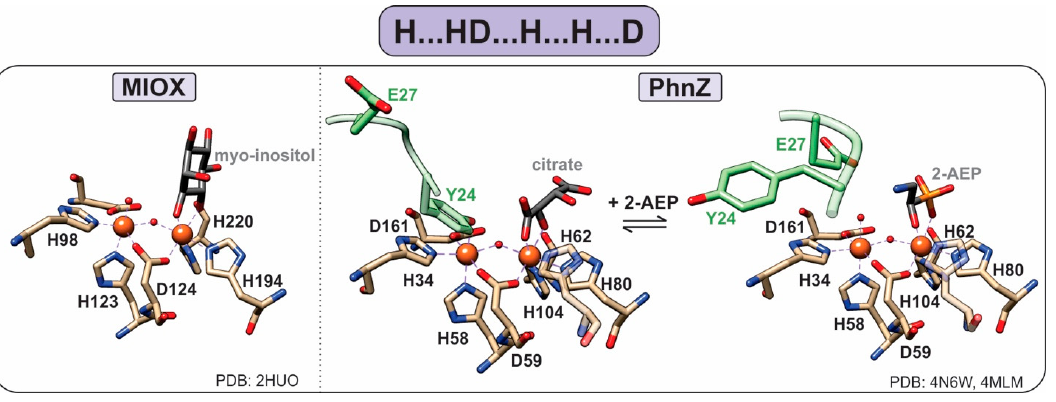
Figure 6. Active sites of HD-domain oxygenases. Oxygenases utilize the “H…HD…H…H…D” motif to bind a diiron metal center. The substrate scissile bond is positioned above one of the iron sites, leaving the second site open for oxygen binding. PhnZ and TmpB contain an YxxE loop (green) in their primary sequence that is located vicinal to the active site, which upon substrate binding undergoes a conformational change to allow for oxygen binding and catalysis.